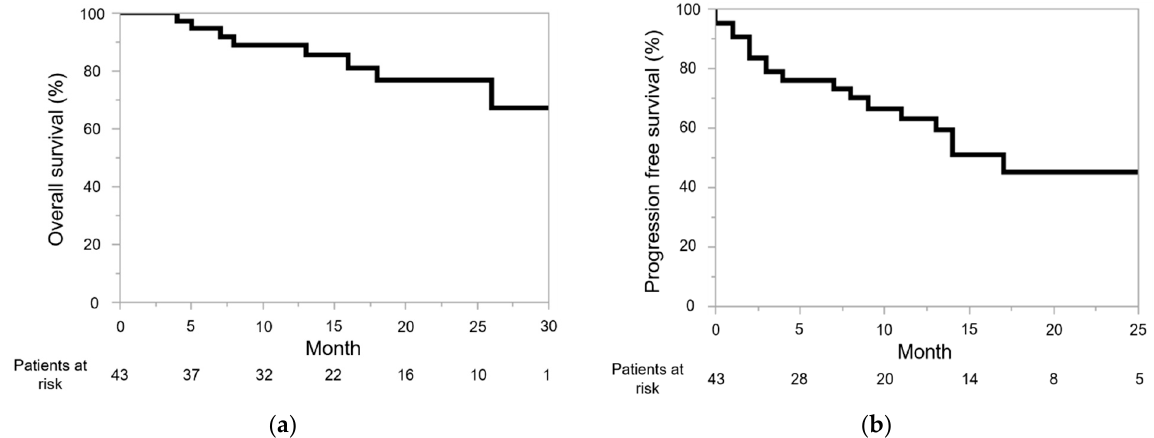
Figure 1. Kaplan-Meier analysis of overall survival (OS) ( a ) and progression-free survival (PFS) ( b ) in patients with metastatic renal cell carcinoma who received nivolumab and ipilimumab. OS at 6 and 12 months is 94.7% and 89.1%, respectively, while PFS is 76.1% and 63.1%, respectively.